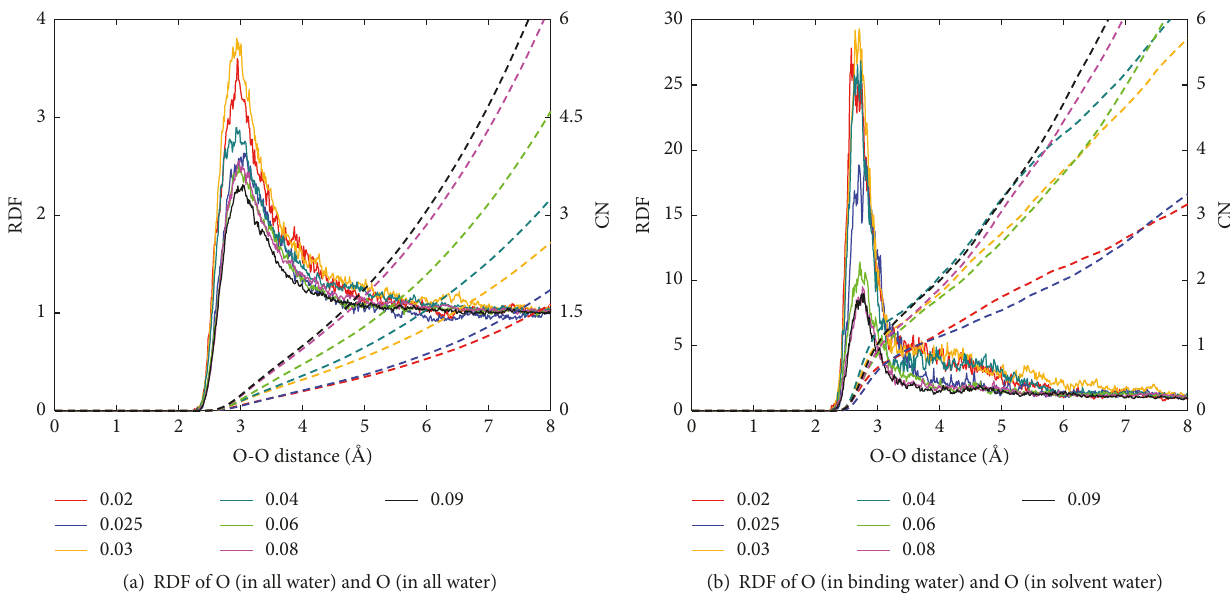
Figure 5: O-O radial distribution function (RDF, solid lines, left axes) and the coordination number (CN, dash lines, right axes) versus the O-O distance. (a) All O in the simulation box; (b) O in the binding water (in [CuCl(H 2 O)] 0 clusters) with O in the solvent water (excluding the water molecule in the [CuCl(H 2 O)] 0 cluster).